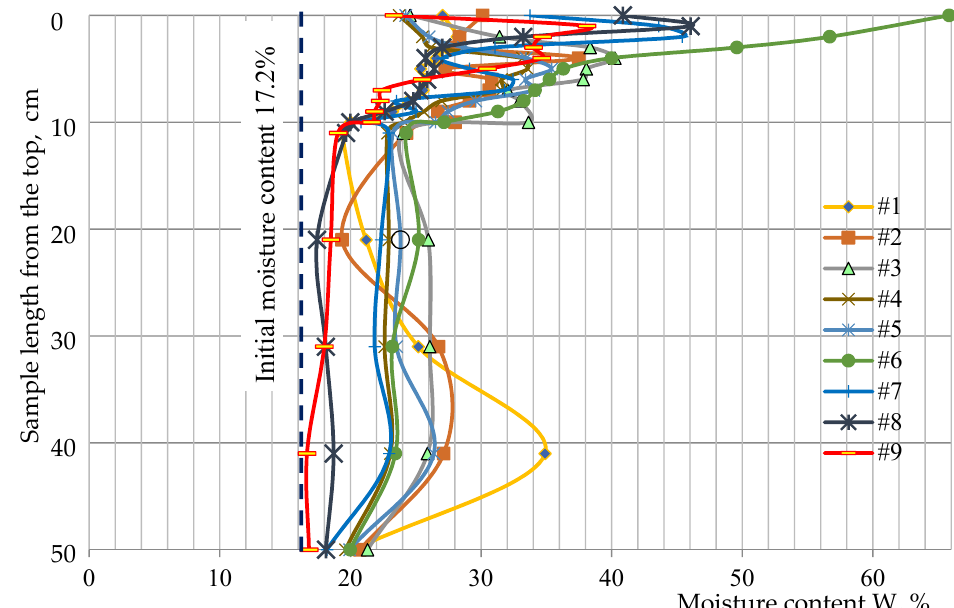
Figure 7. Moisture redistribution after freeze–thaw cycles in columns #1–#9.